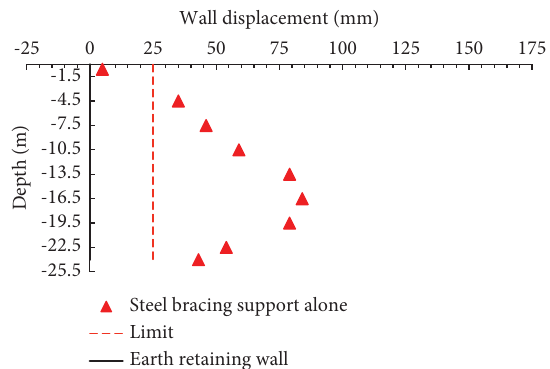
Figure 6: Influence of the application of steel bracing support alone on wall lateral displacement profile.